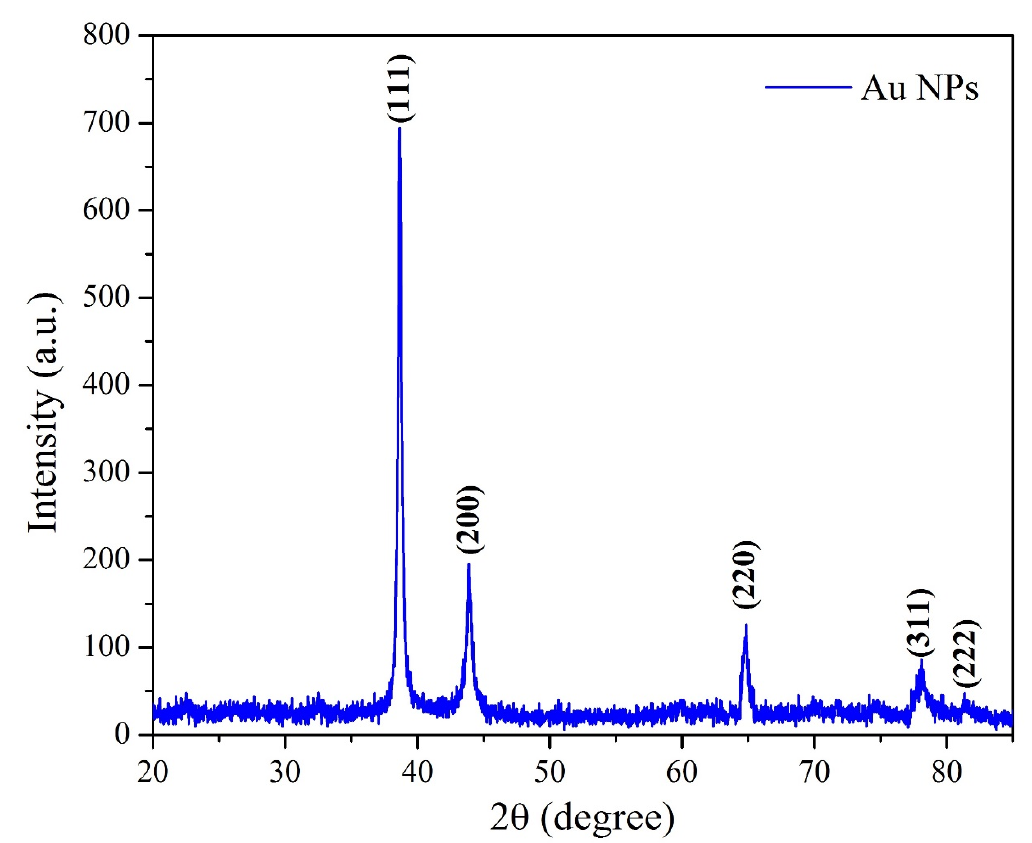
Figure 6. Analysis of elemental composition by EDAX.